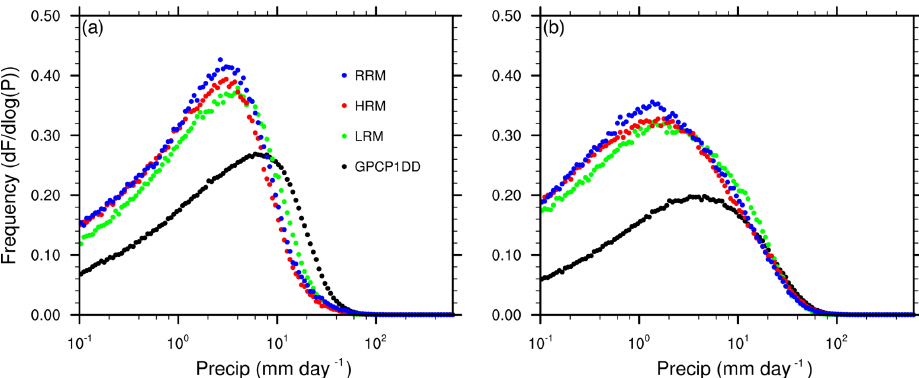
Figure 14. Daily mean precipitation frequency (unit: d F/ dlog (P) ) functions of total precipitation for the GPCP1DD observation (black), and model simulations: LRM (green), HRM (red), and RRM (blue) in (a) JJA and (b) DJF. Before deriving the distribution, precipitation rates (unit: mmd − 1 ) are interpolated to 1 ◦ × 1 ◦ grids and averaged over daily